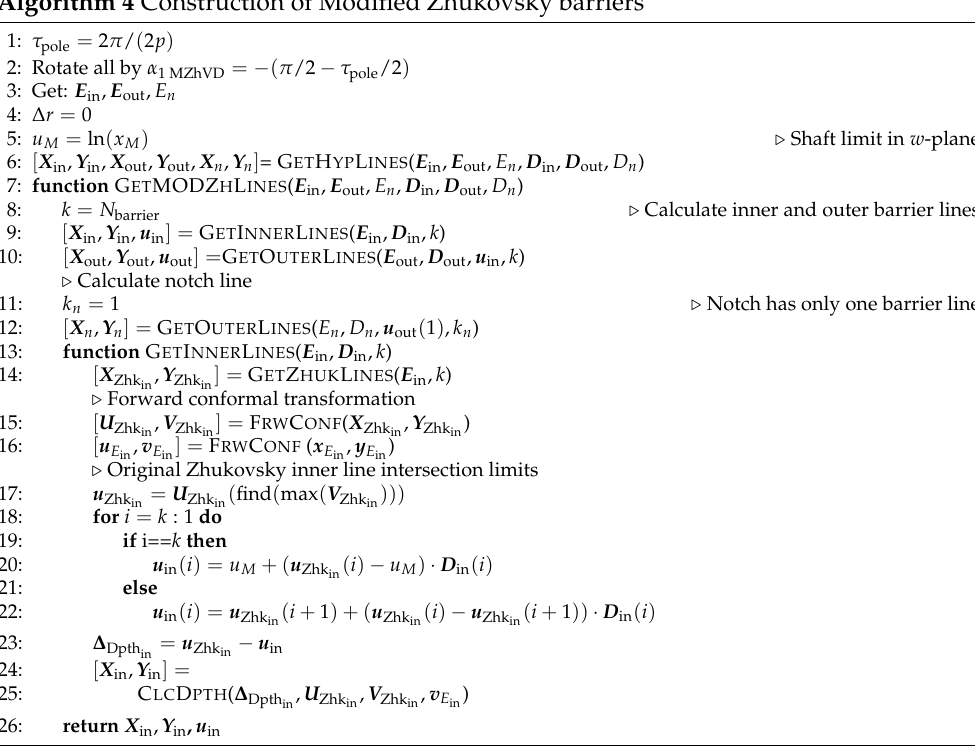
Algorithm 4 Construction of Modified Zhukovsky